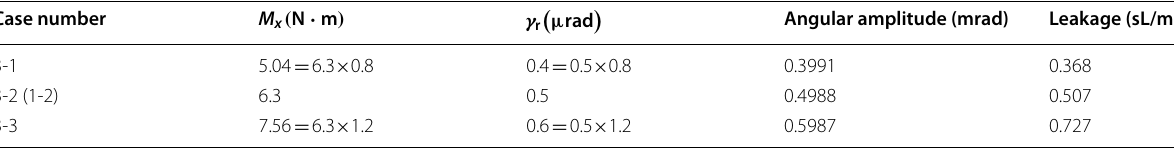
Table 4 Group 3: Scaling of the moment and the